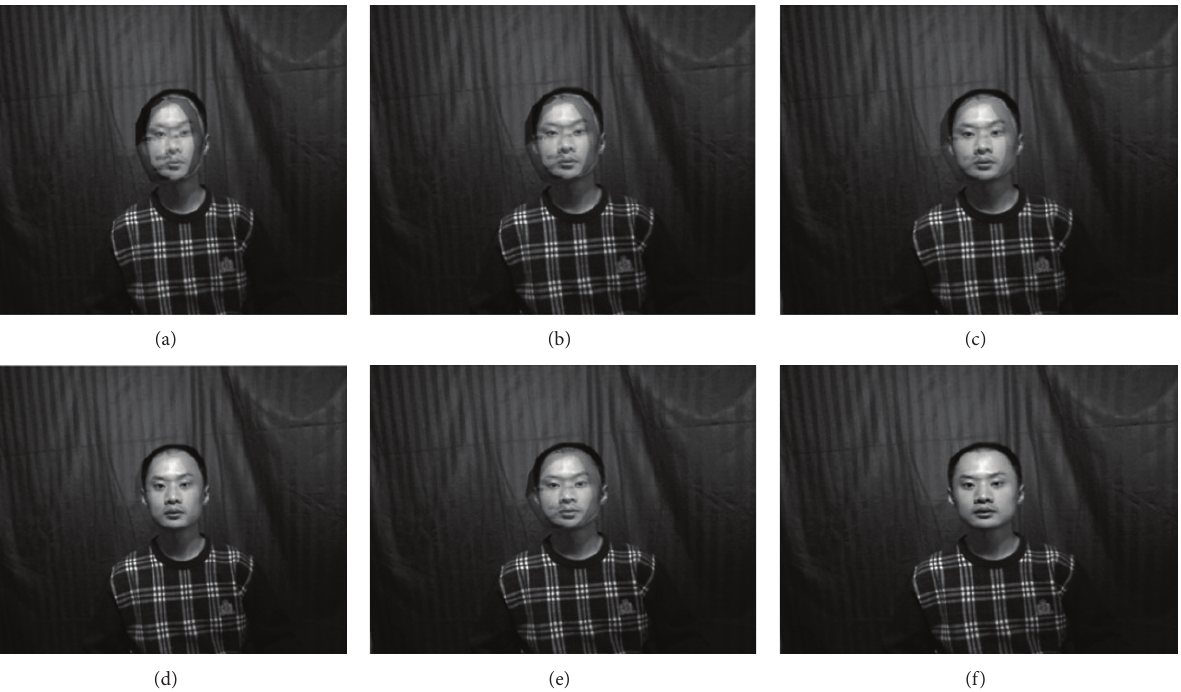
Figure 7: Fitting model example of faces at (a) iteration 1, (b) iteration 2, and (c) iteration 3, (d) final fit model, (e) standard AAM image, and (f) original image.